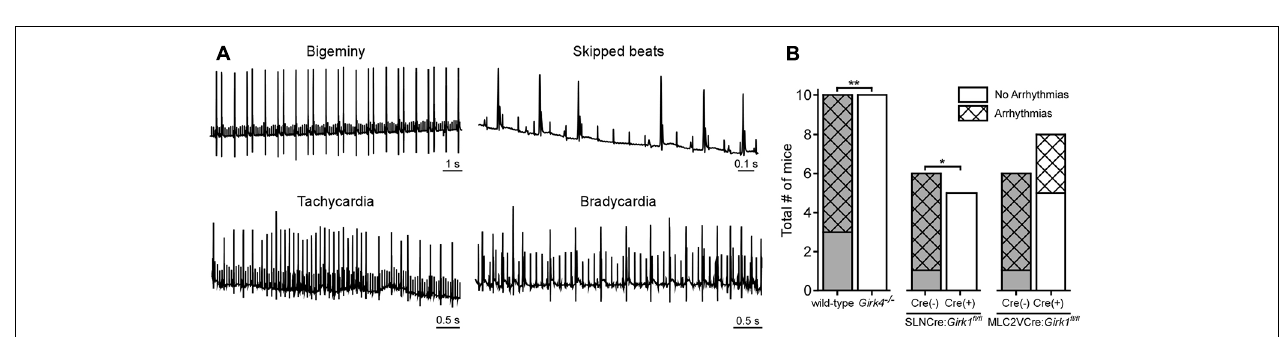
FIGURE 6 | Impact of whole-heart and tissue-specific GIRK channel ablation on VNS-induced arrhythmogenesis. (A) Representative segments of ECG recordings of arrhythmias (bigeminy, skipped beats, bradycardia, and tachycardia) observed during VNS. (B) Total number of mice exhibiting arrhythmic episodes during VNS. Fisher’s exact test revealed a significant difference in arrhythmia incidence between wild-type ( n = 10) and Girk4 − / − ( n = 10) mice ( ∗∗ P < 0.01), and SLNCre(–): Girk1 fl / fl ( n = 6) and SLNCre(+): Girk1 fl / fl ( n = 5) mice ( ∗ P < 0.05), but no difference between MLC2VCre(–): Girk1 fl / fl ( n = 6) and MLC2VCre(+): Girk1 fl / fl ( n = 8) mice ( P =